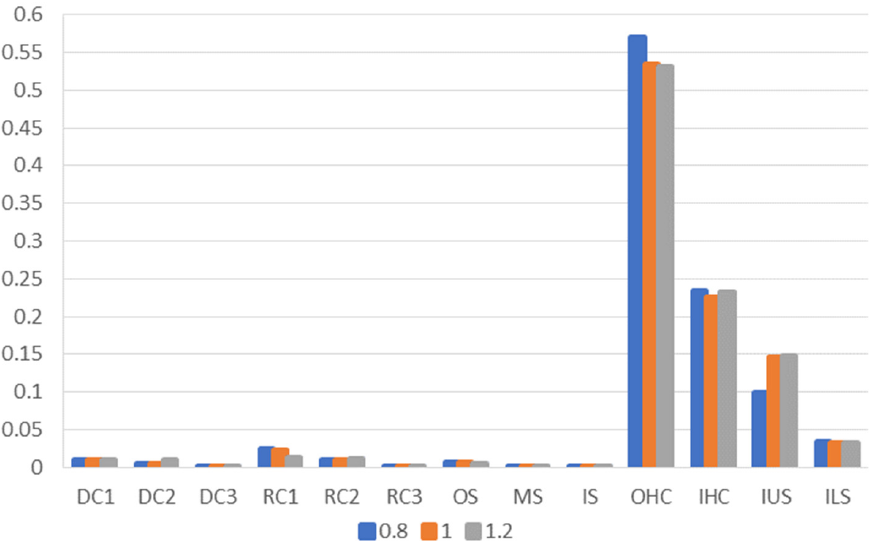
Figure 9. Variations in the importance coefficients of different elements with variations in the length of the